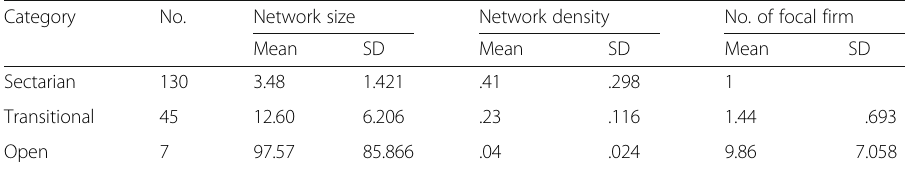
Table 1 Structural characteristics of the three categories of financing trust network Category No. Network size Network density No. of focal firm